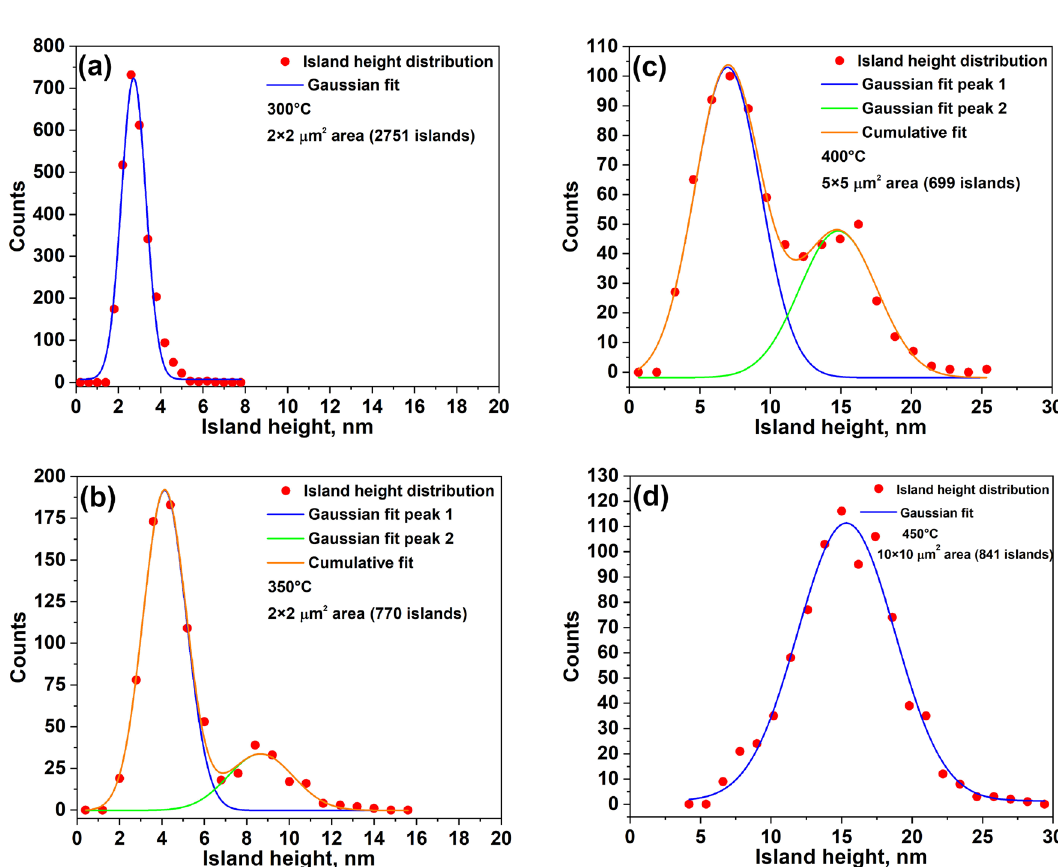
Figure 5. The GaAs island height distribution of samples (a) T1, (b) T2, (c) T3, and (d) T4. For the samples T1 and T4 an unimodal distribution is observed with a standard deviation of about 44%. The samples T2 and T3 have a bimodal